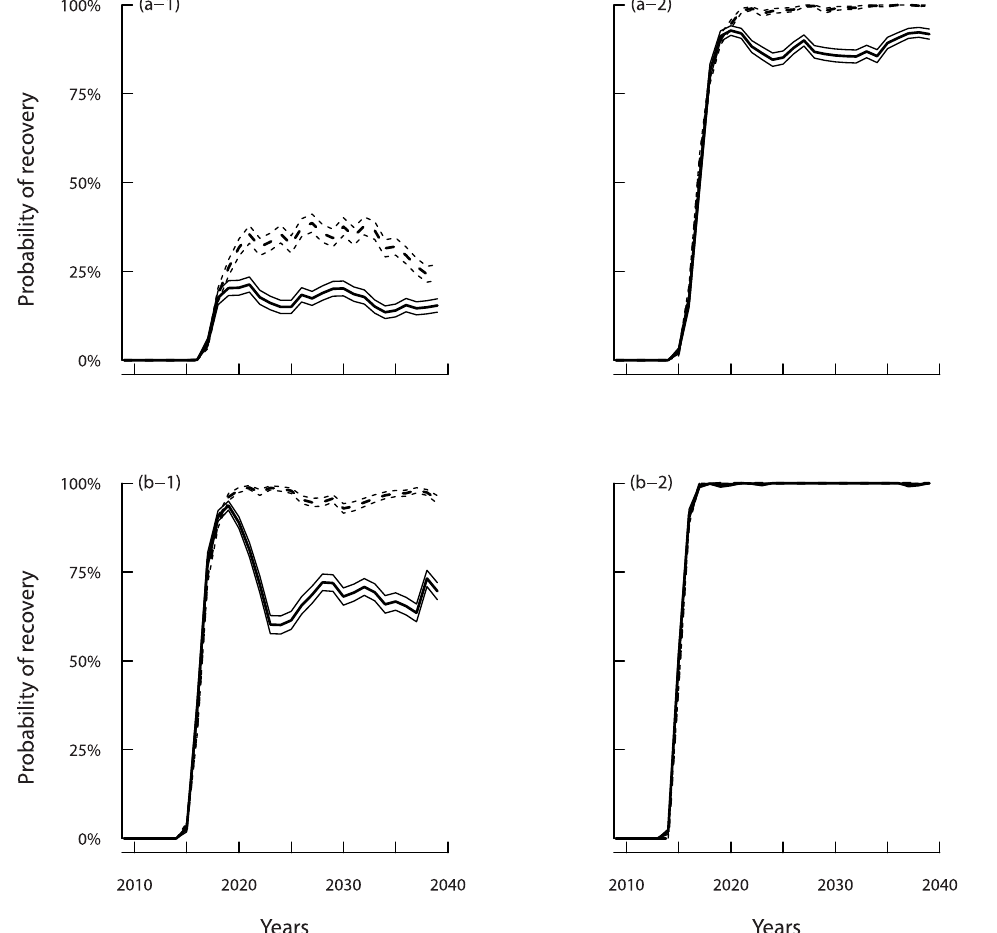
Figure 7. Probabilities-at-year for the SSB to exceed the limit of recruitment overfishing B lim . Alternative fishing management strategies, levels of seal reduction, and environmental conditions are considered. (a) Current environmental conditions (CIL=0.25 u C) for 30% (a–1) and 50% (a– 2) seal reduction. (b) Warming environmental conditions (CIL=0.75 u C) for 30% (b–2) and 50% (b–3) seal reduction. Plain and dashed lines indicate the effects of reduced catch and cod fishery moratorium, respectively. Mean and 95% confidence intervals of the probabilities are